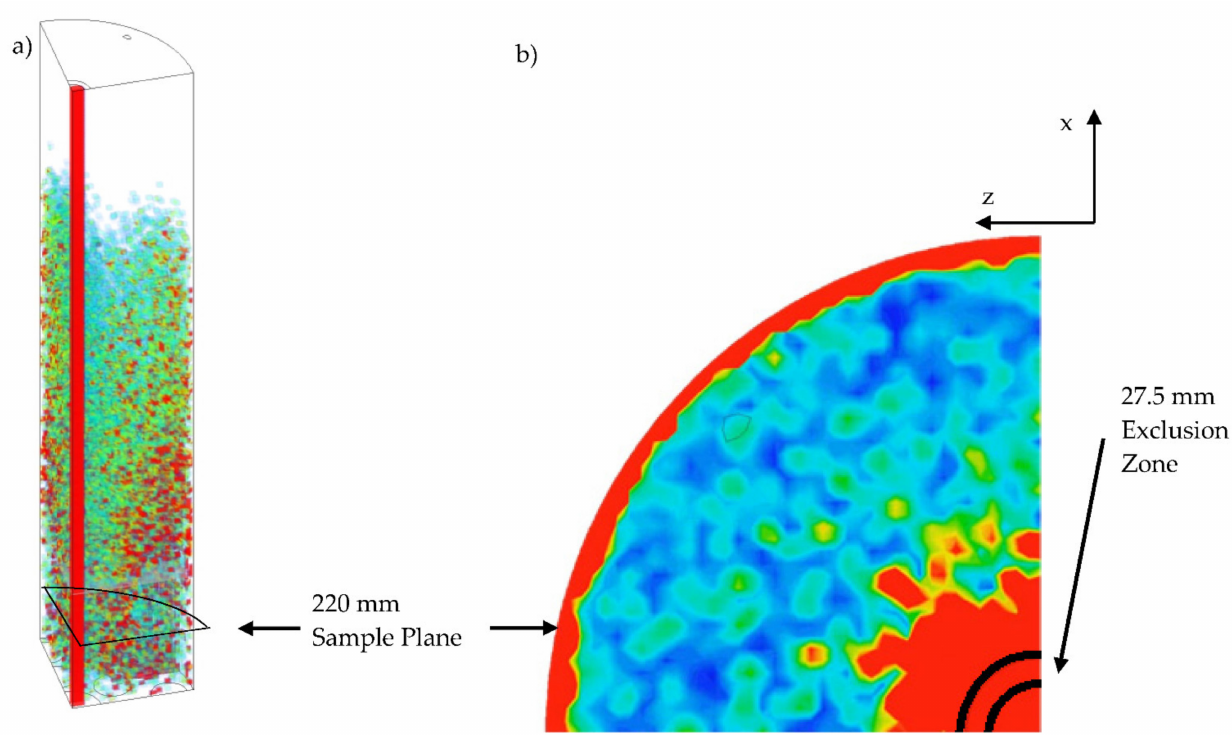
Figure 16. ( a ) Isometric view of the 3D silo highlighting the 2D sample plane location. ( b ) Top view of the 220 mm sample plane depicting the particle mass concentrations used in the simulation analysis.